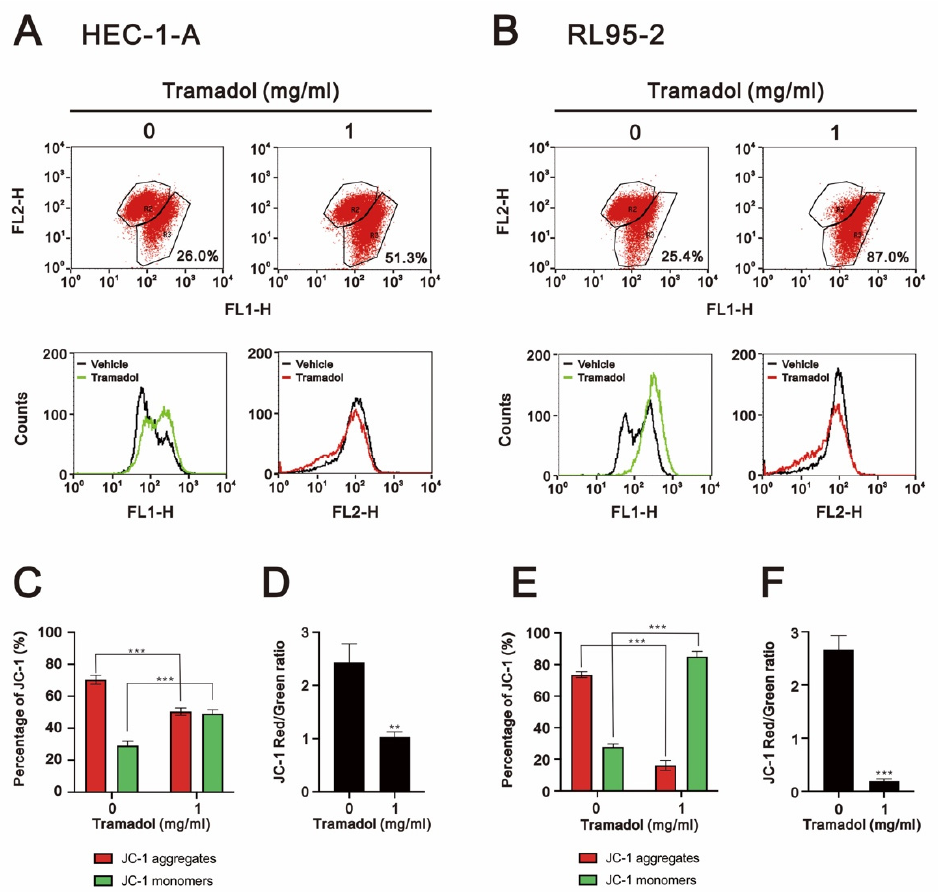
Figure 5. Effects of tramadol on the mitochondrial membrane potential of human endometrial cancer cells. ( A , B ) HEC-1-A and RL95-2 cells were treated with tramadol (0 and 1 mg/mL) for 24 h. Mitochondrial membrane potential was assessed using JC-1 staining with flow cytometry. ( C , E ) The percentages of red and green fluorescences were plotted. ( D , F ) The red/green fluorescence intensity ratios were measured and plotted. Bars depict the mean ± SD of three independent experiments. Student’s t -tests were performed, and the results were compared with the vehicle. ** p <0.01 and *** p < 0.001 (Student’s t -test).